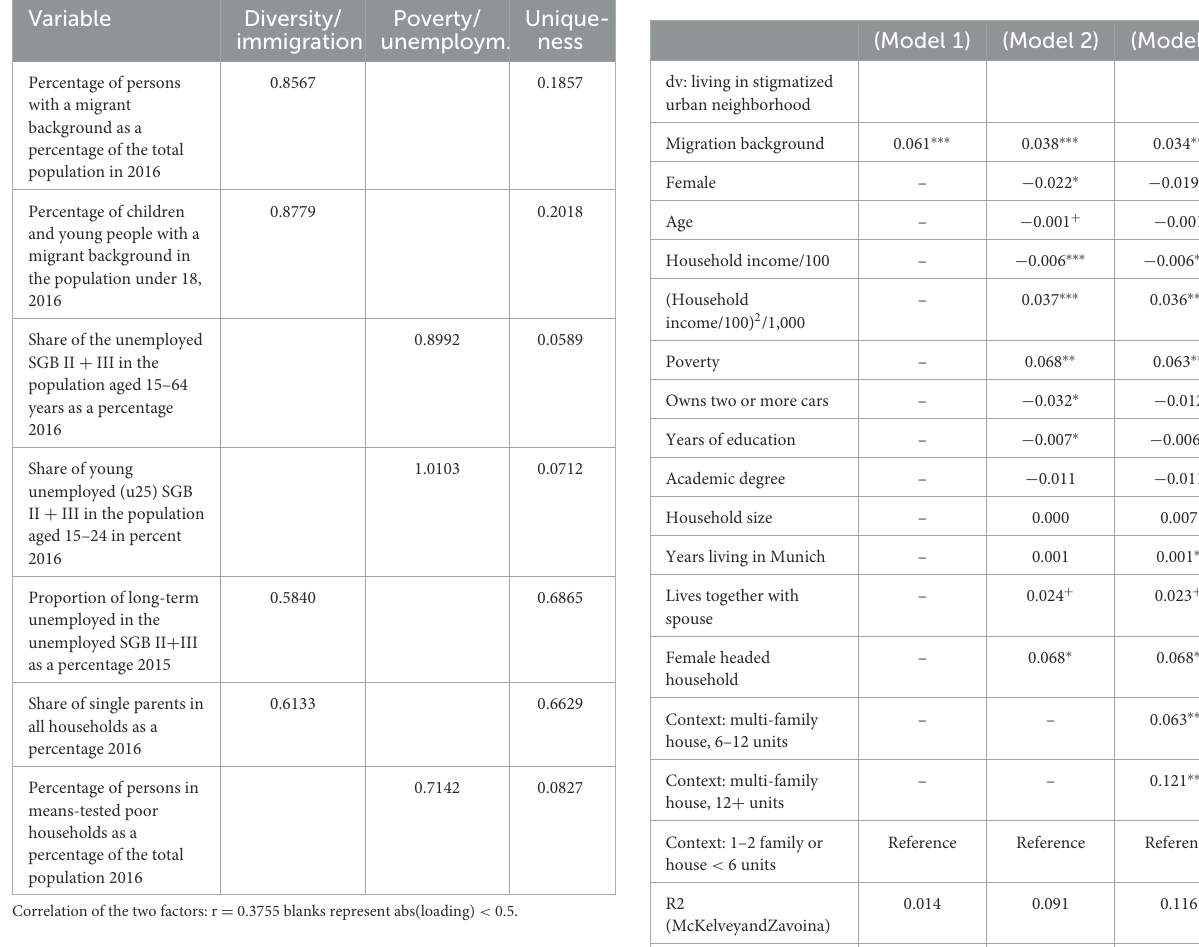
TABLE 4 Determinants of living in a stigmatized urban neighborhood in Munich, logistic regression, average marginal effects, k = 360 small scale